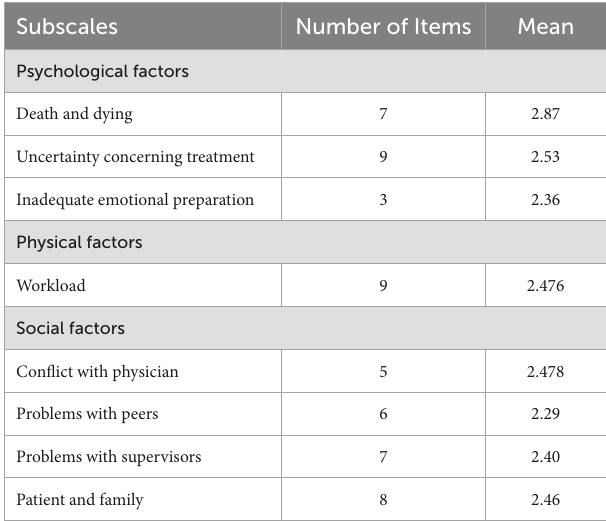
TABLE 3 Mean score of response of nurse to ENSS in Addis Ababa public hospitals, Ethiopia, 2022 ( N = 414).